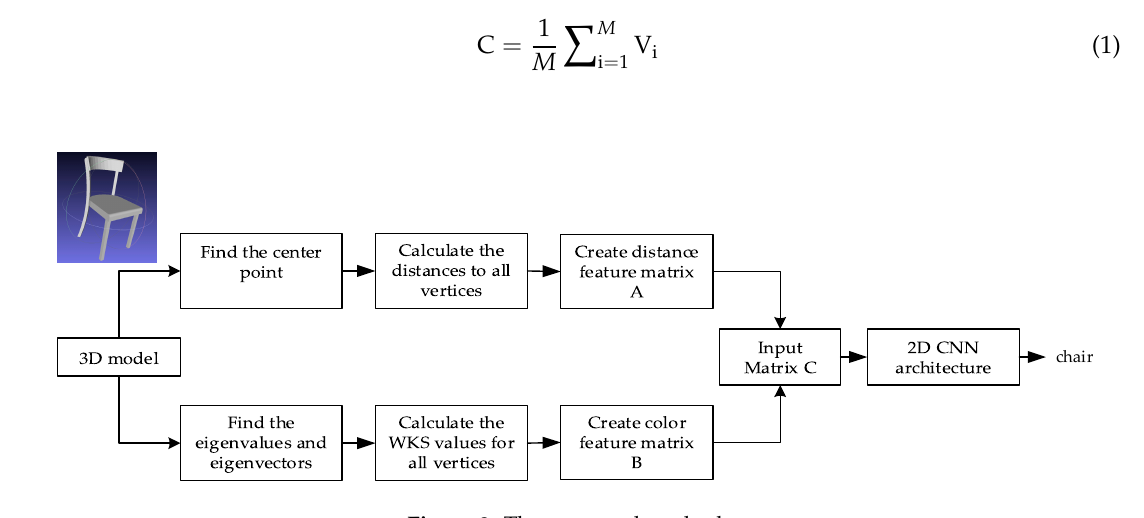
Figure 3. The proposed method.